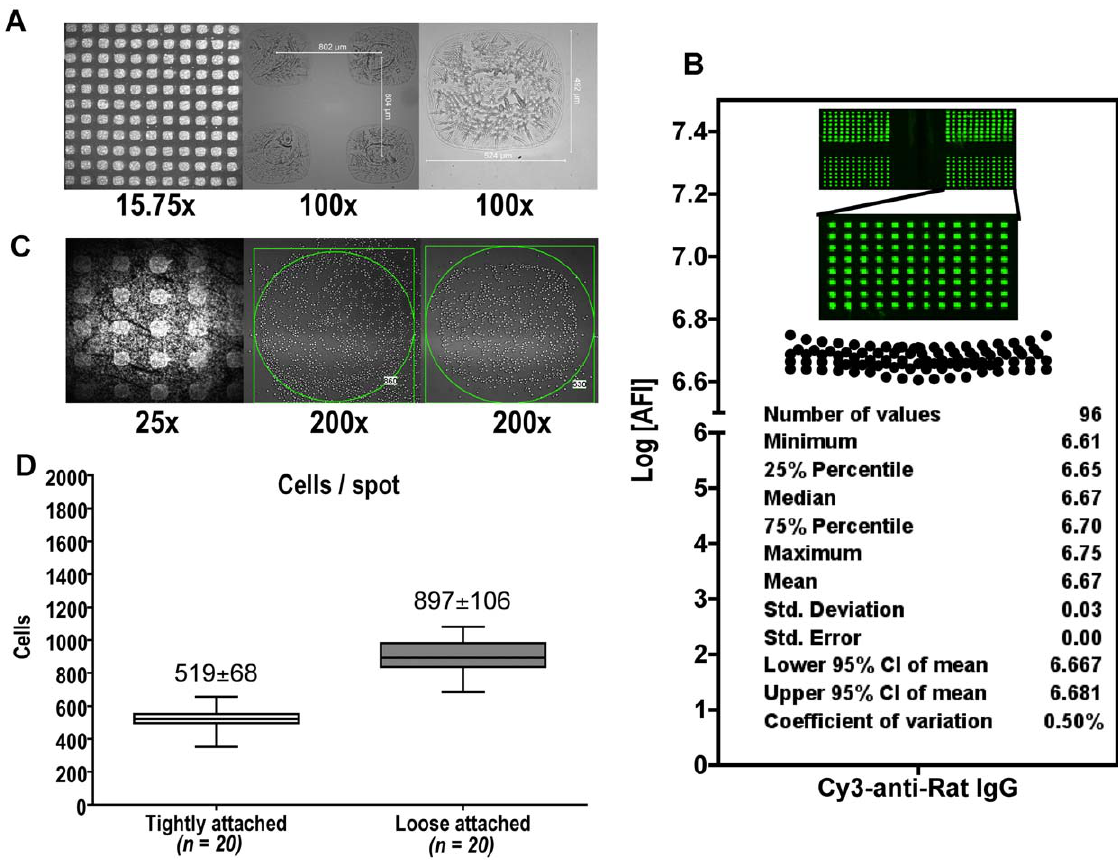
Figure 1. Characteristics of peptide:MHC cellular microarrays. (A) A part of a freshly fabricated microarray image with magnification of 15.75 6 (left panel), 100 6 (middle panel) and 200 6 (right panel). (B) A raw fluorescence image of a 4-supergrid 8 6 12 microarray probed with Cy3- conjugated anti-Rat-IgG. The absolute fluorescence of all 96 spots for the low-right supergrid was quantified and analyzed for the variance. (C) A microarray loaded with 6 6 10 6 primary human CD4 T cells. (Left panel, 25 6 magnification) image taken immediately after 6 hours of incubation; (middle panel, 200 6 magnification) image taken after aspirating culture medium; (right panel) image taken after washing the slide with 1xPBS for three times. The numbers at the low-right corners of middle and right panels indicate cell counts. (D) The box/whisker plots represent cell counts of 20 randomly selected spots before (loose attached) and after (tightly attached) washing procedure.